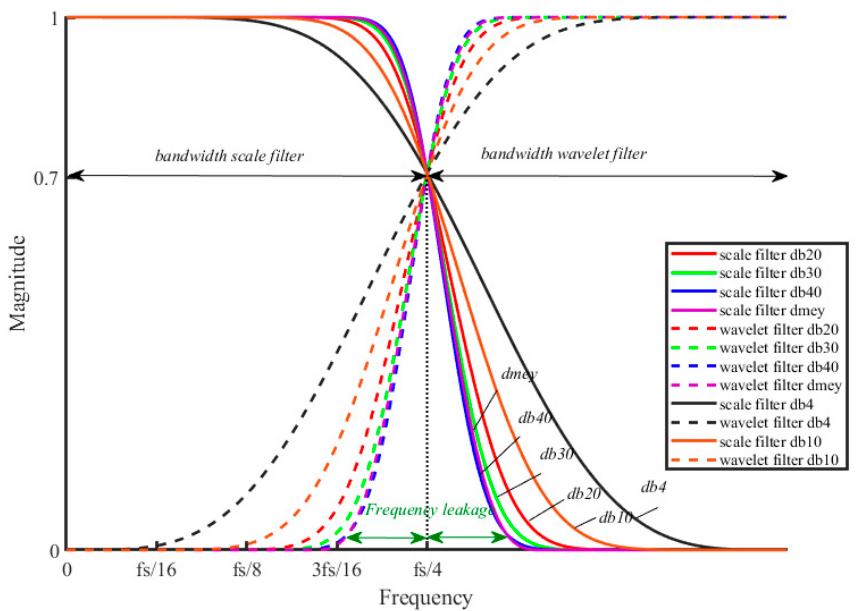
Figure 1. Comparative frequency response of mother wavelets.